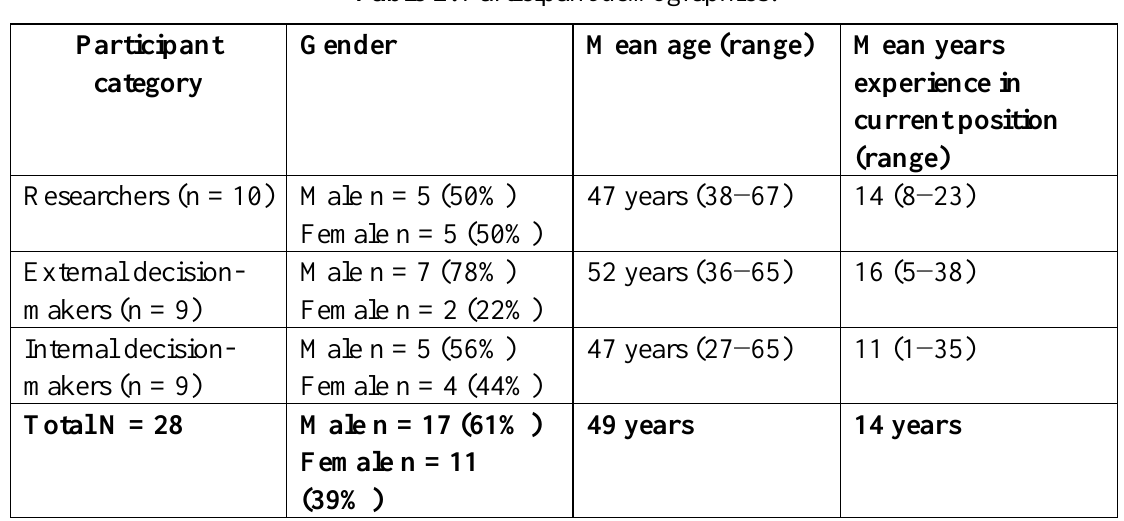
Table 2. Participant